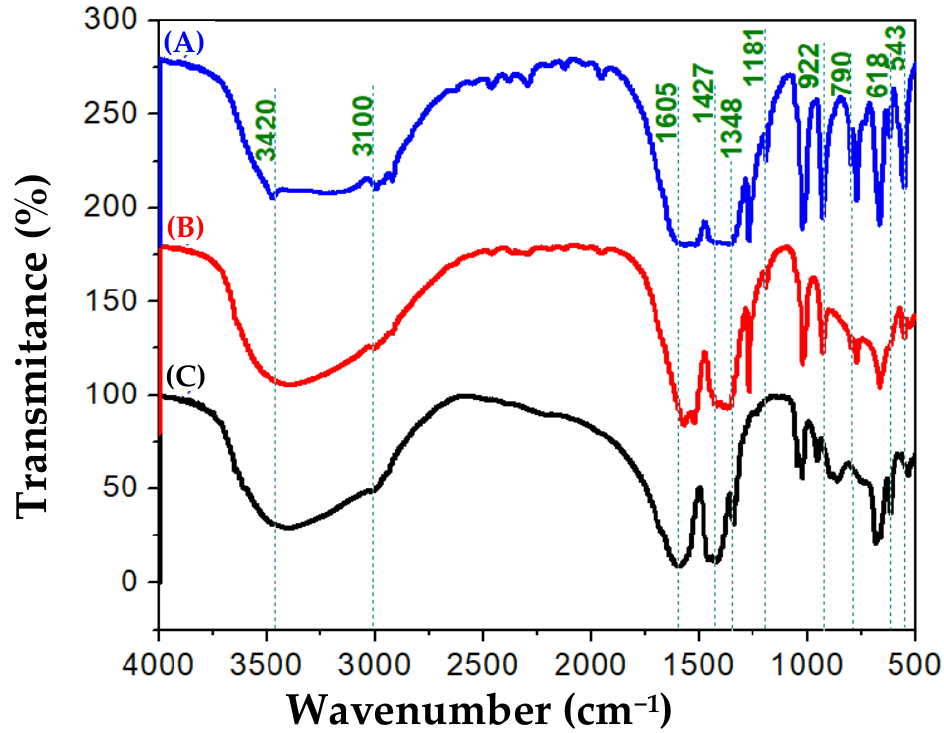
Figure 4. FTIR spectra of ( A ) Ni50-Fe50 wt%, ( B ) Ni80-Fe20 wt%, and ( C ) Ni90-Fe10 wt% samples.